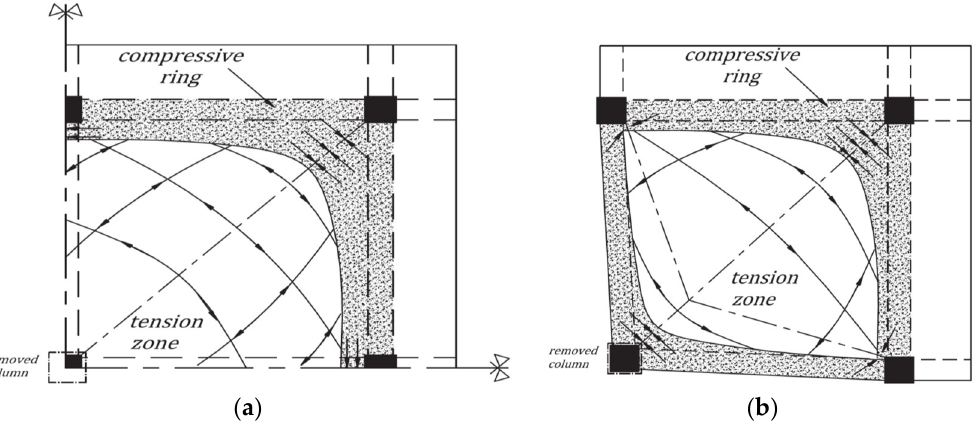
Figure 23. Tensile membrane action (TMA) in RC slabs: ( a ) Internal failed column and ( b ) Corner failed column [76]. Table 10. Results of FE modelling for all